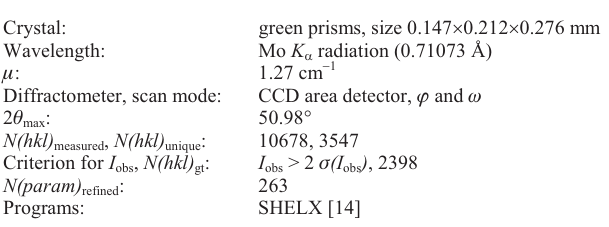
Table 1. Data collection and handling.